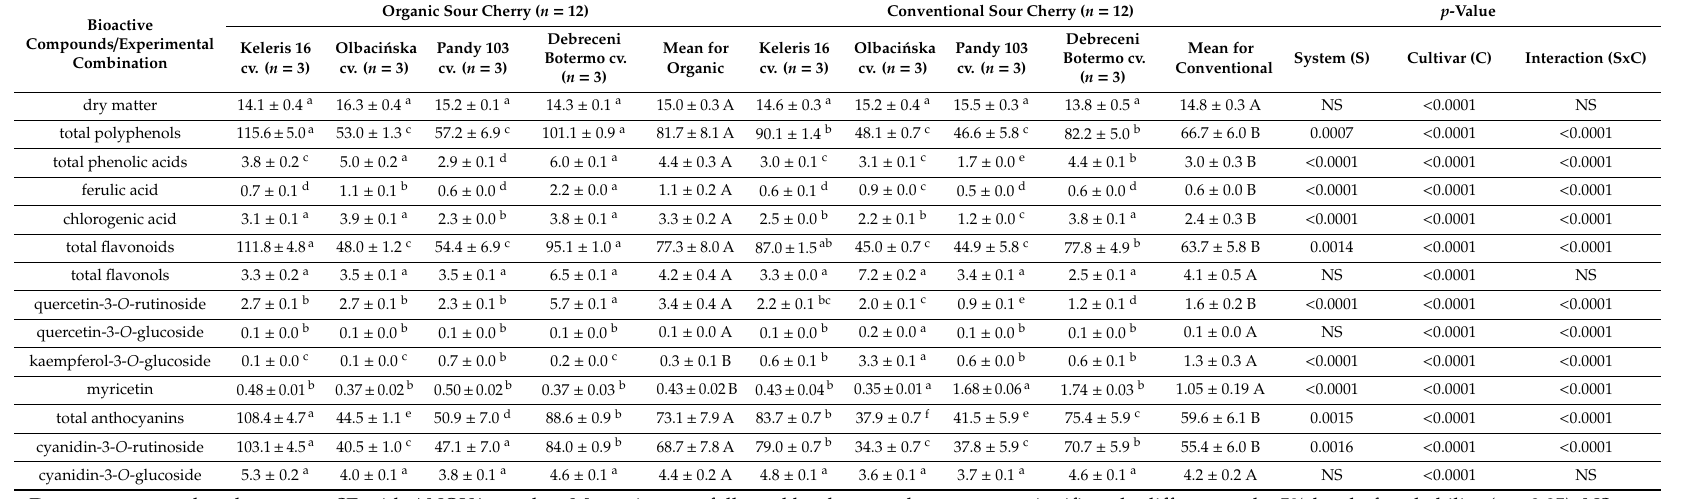
Table 4. The content of dry matter (in g / 100 g FW) and polyphenols (in mg / 100 g FW) in examined sour cherry cultivars in